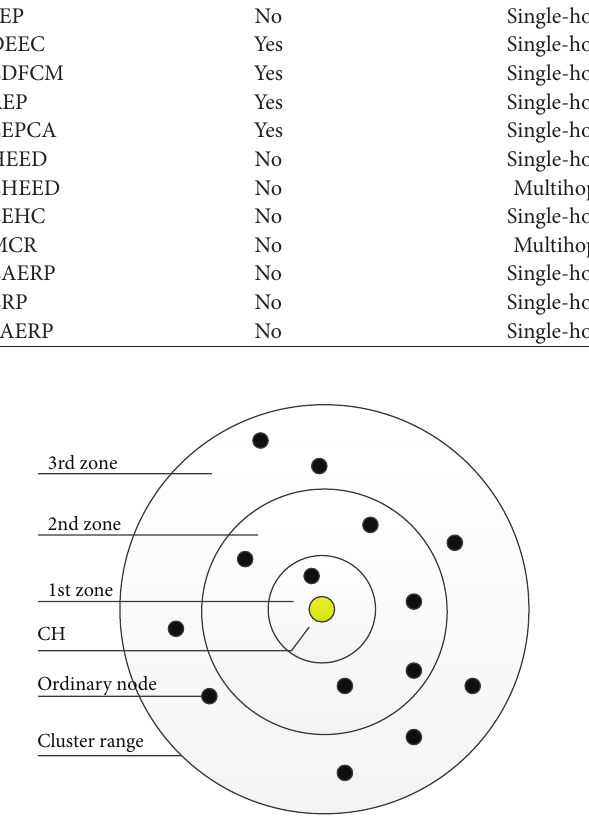
Figure 1: An example of cluster